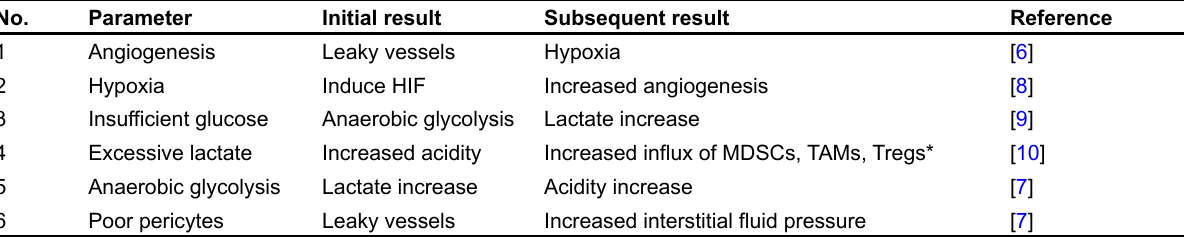
Table 1. The main sequence of events occurring in the TME No.